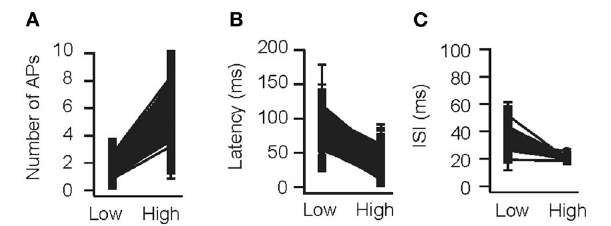
FIGURE 3 | Concentration dependence in the model. Validation of the OB model for variable odor concentrations. An odor was presented to the OB model at concentrations of 0.3 (“low”) and 3 (“high”) times relative to the concentration used in B (see methods). The number of APs per cycle (A) , latency to the first AP (B), and average ISI (C) were